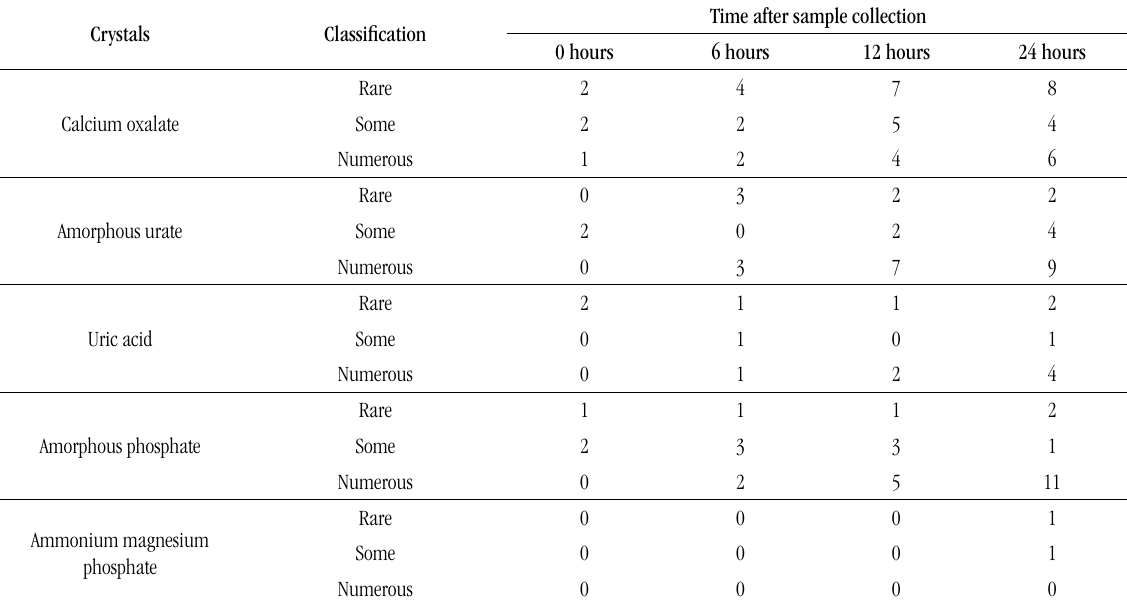
tABLE 4 – Absolute number of crystal findings in non-refrigerated urine samples (time zero) and after refrigeration (6, 12 and 24 hours after